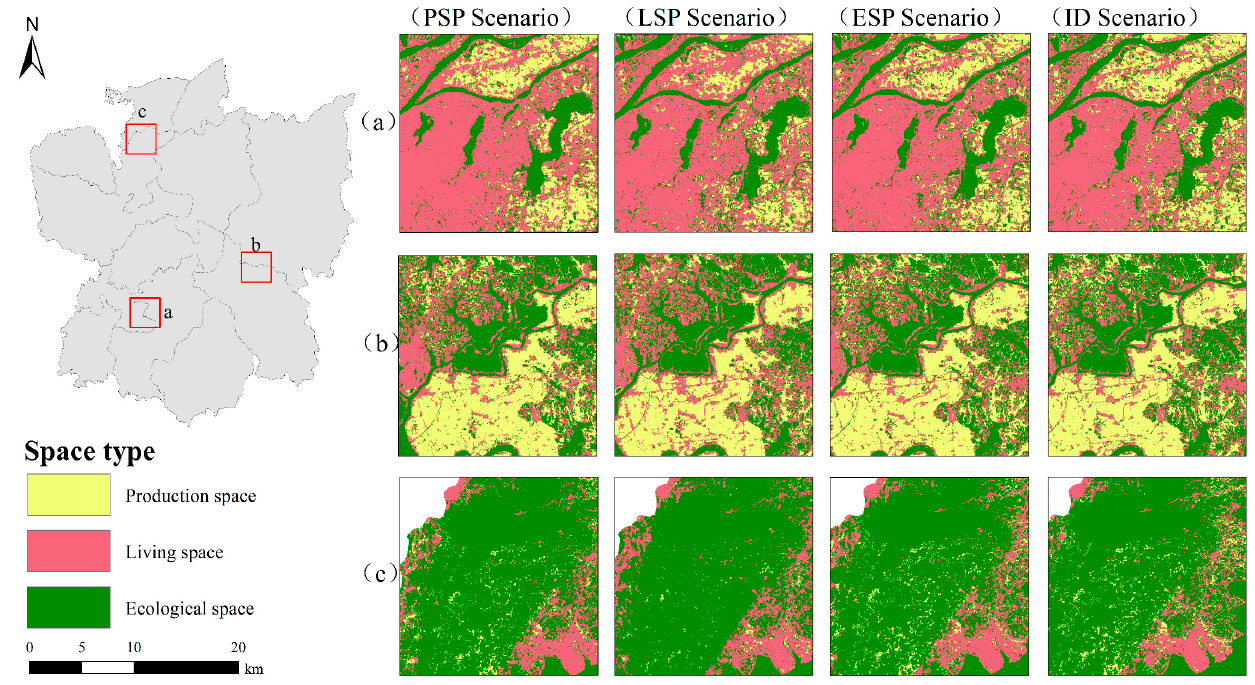
Figure 10. Simulation of PLE space for typical regions under the multi-scenario in 2030. ( a ) Changes in the obvious urban sprawl of Nanchang in 2030 under multiple scenario simulations ( b ) Changes in the concentrated cropland area in the northern part of Yugan County in 2030 under multiple scenario simulations ( c ) Changes in the national ecological reserve in Lushan in 2030 under multiple scenario simulations.